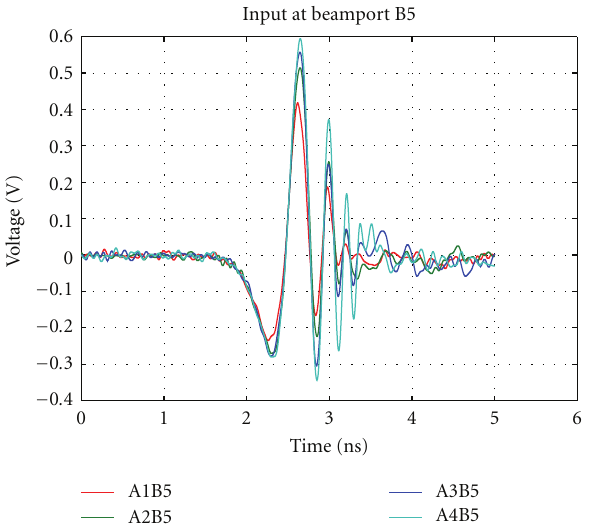
Figure 9: Measured output transient pulses of the Rotman lens for feeding B5.